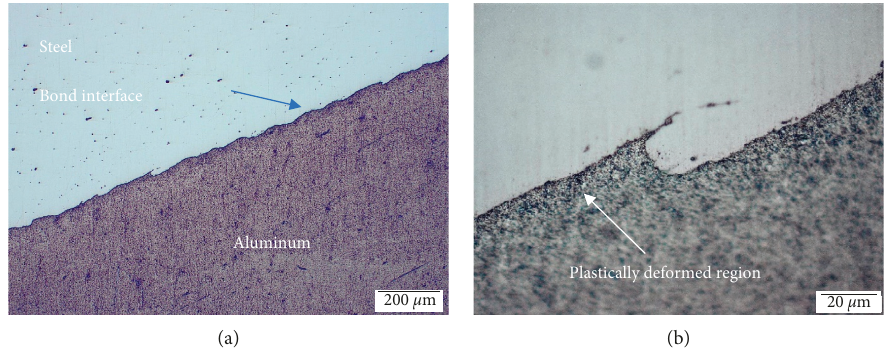
Figure 4: Metallographic images of the welded joint. (a) 100x magnification and (b) 1000x magnification.